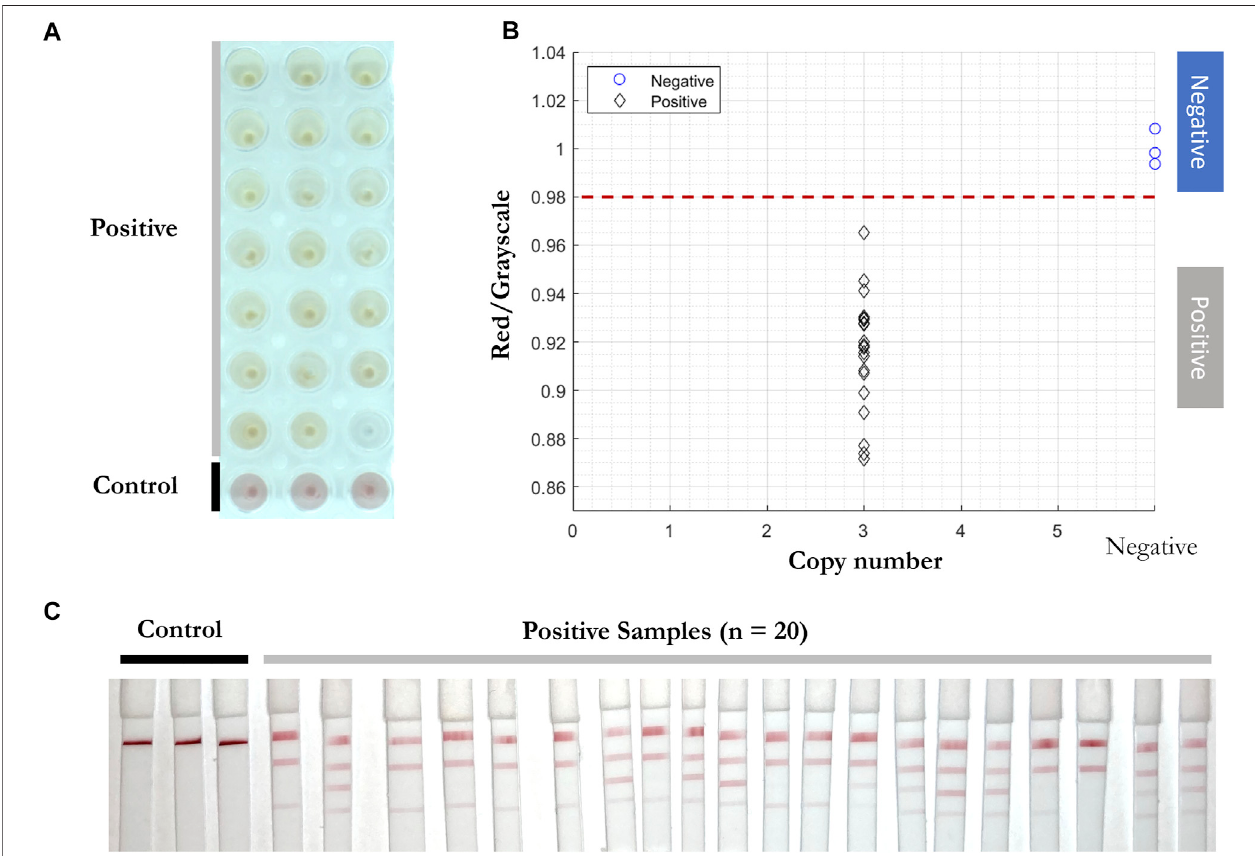
FIGURE6| ReproducibilitytestofRT-LAMP-LFIAprototypesystematthelowerlimitofdetection. (A) RT-LAMPproductsfrom3initialtemplatecopies( n =20)and negativecontrolsamples( n =3)afterthereaction,takenbyoverviewcamera. (B) Red/grayscalevs.copynumbersofbothpositiveandnegativesamples. (C) LFIAread- outs for RT-LAMP products ampli fi ed for all three